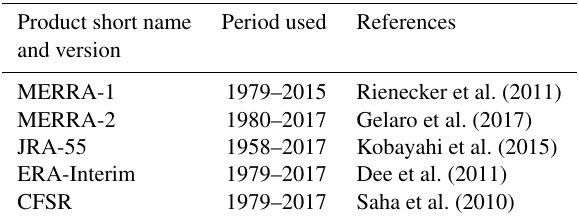
Table 3. The reanalysis